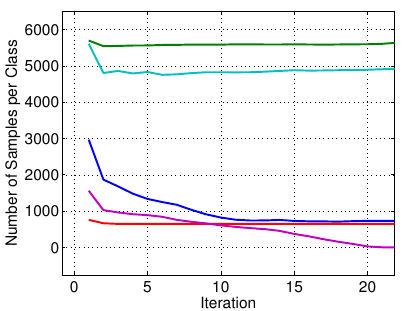
(b) Overall classification result for each iteration.